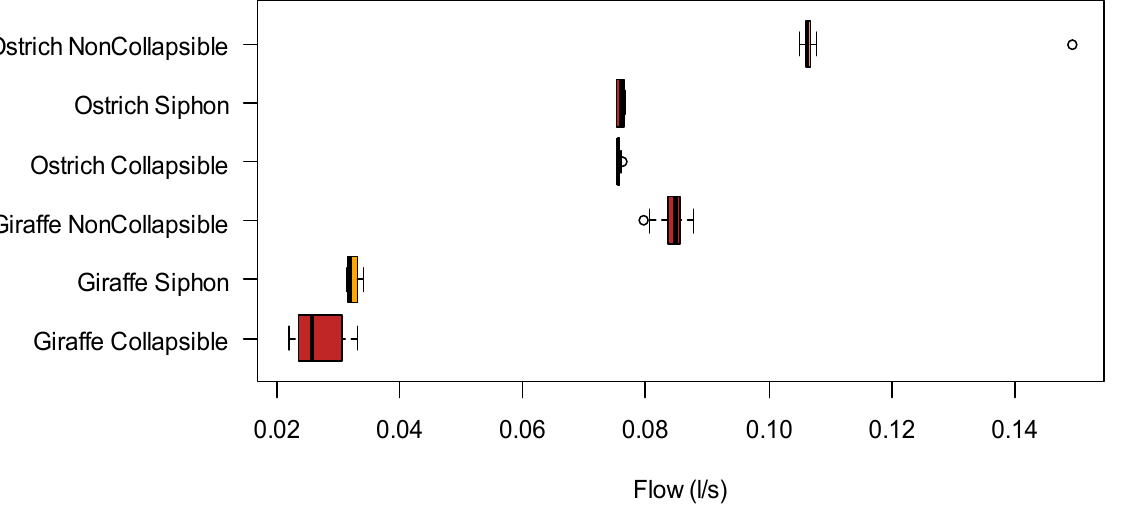
Figure 6. The box plot illustrates the braincase measurements for both the giraffe and ostrich.